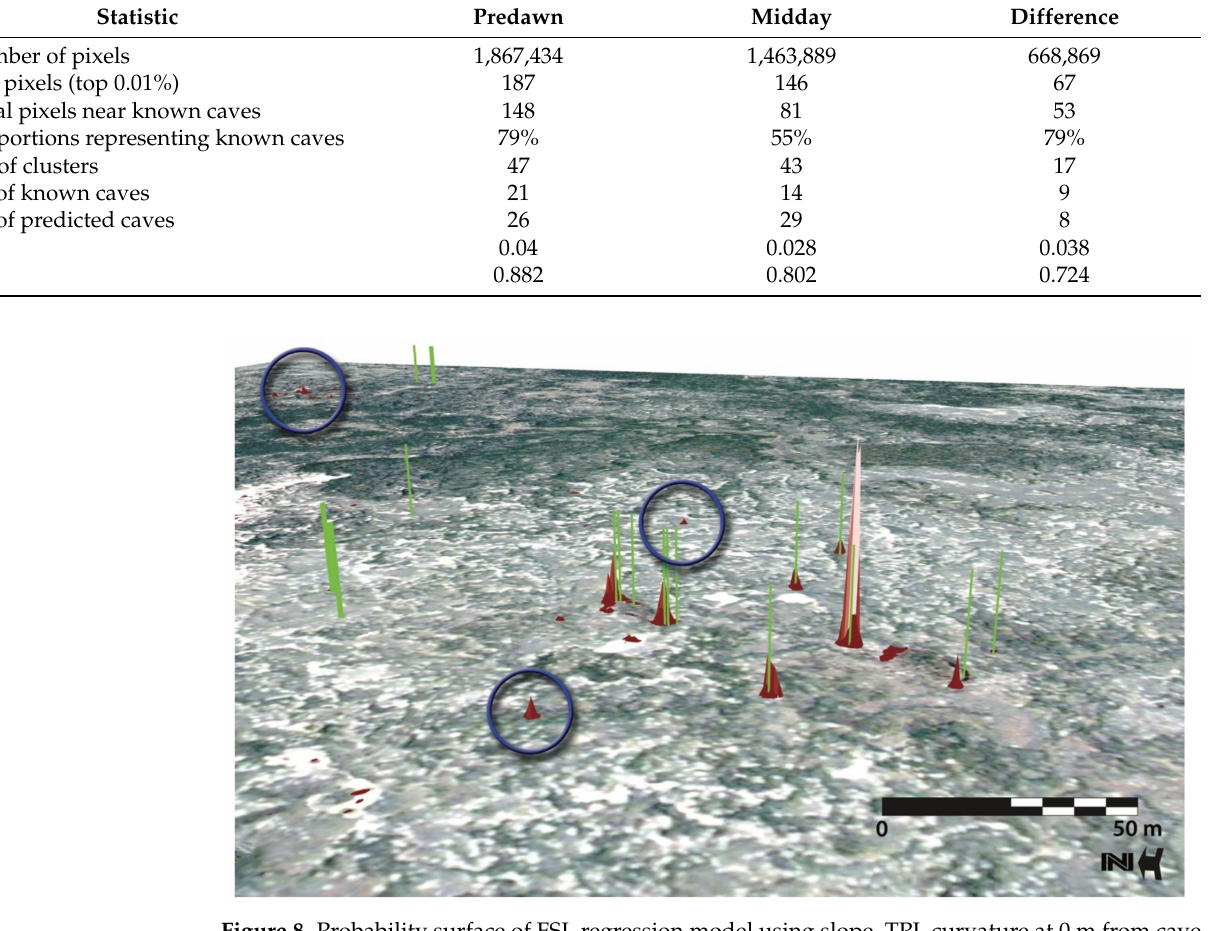
Figure 8. Probability surface of FSL regression model using slope, TPI, curvature at 0 m from cave entrance, and slope at 1 m from cave entrance for the predawn imagery, Pisgah Lava Field, Mojave Desert, CA, USA. Red peaks protruding from surface layer represent caves (confirmed and predicted), green vertical lines represent confirmed caves, and blue circles denote the locations of predicted